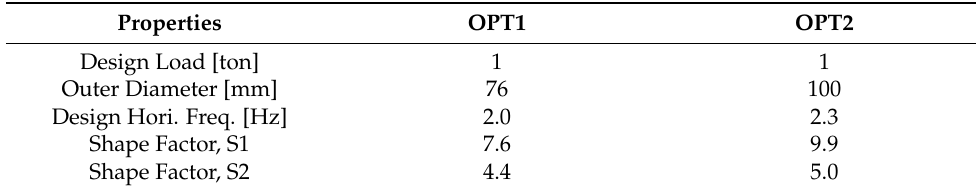
Figure 1. Cross-sectional shape of the LRB. Table 1. Design options of the LRB for nuclear components.